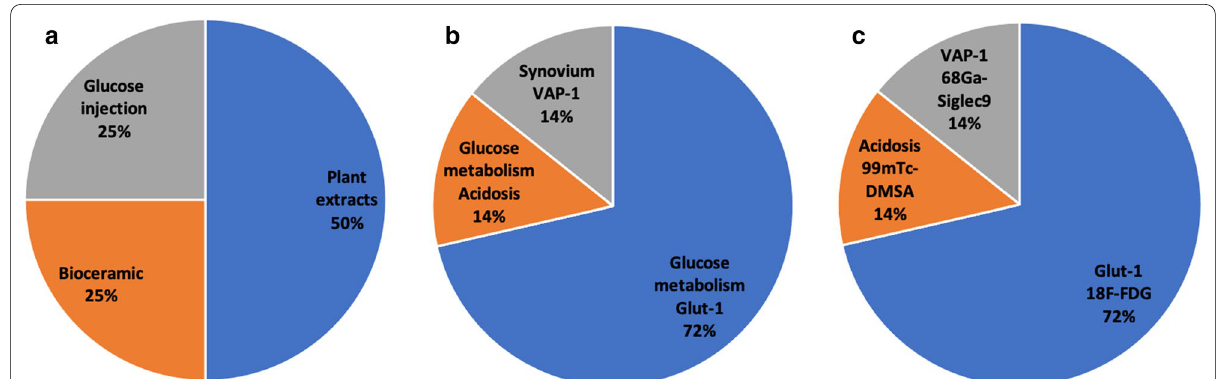
Fig. 3 Overview of the type of interventions reported in New Zealand White rabbits ( a ) and the imaging tracers and targets described in these studies ( b , c )